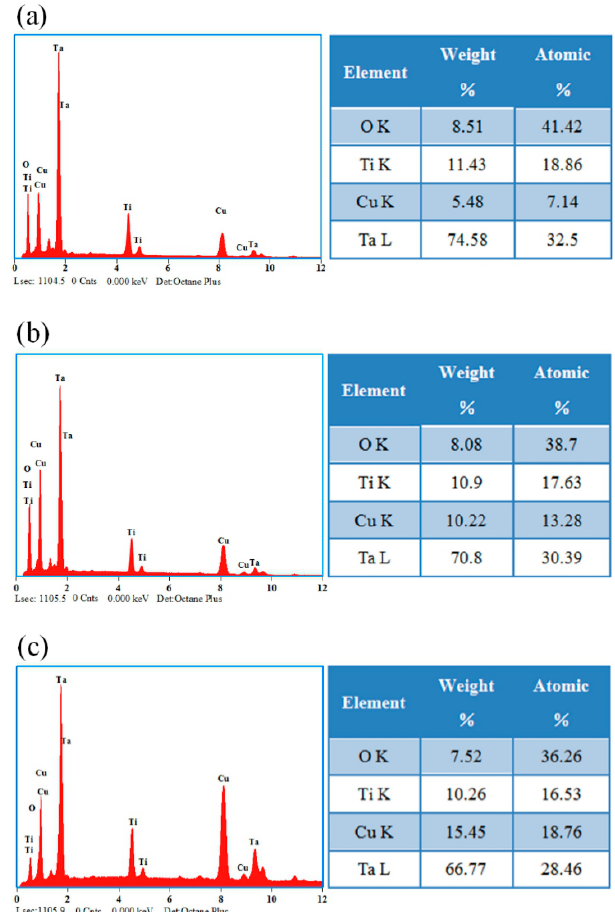
Figure 5. Energy dispersive spectroscopy (EDS) spectra images of coated samples: ( a ) C1, ( b ) C2 and ( c ) C3.